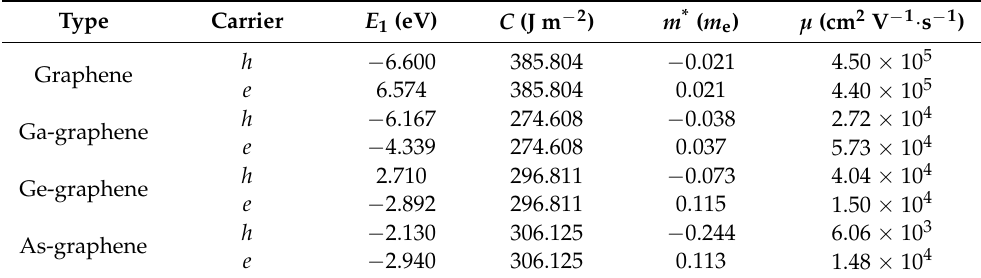
Table 2. The in-plane stretching modulus C , carrier mobility µ at 300 K, effective mass m * , based on effective mass method for pristine and ion-implanted